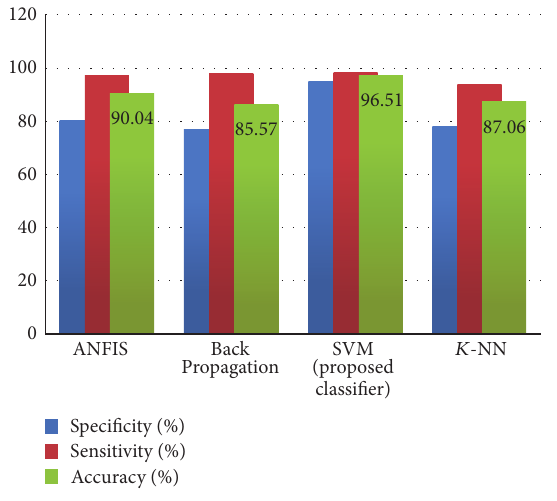
Figure 7: Comparative analysis of